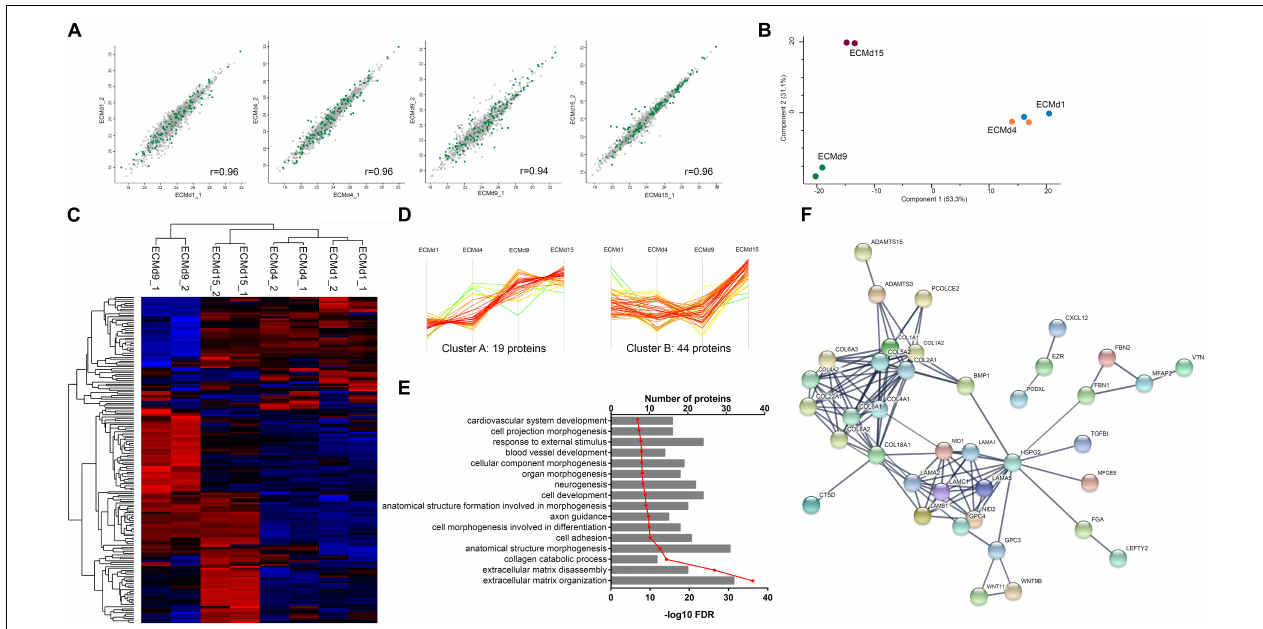
FIGURE 3 | Characterization of extracellular matrix obtained from decellularized EBs during cardiac differentiation of hESCs. (A) Pearson’s correlation of ECM replicates. (B) Principal component analysis of all analyzed samples. (C) Heatmap representing the hierarchical clustering of ECM samples. High z -scores and low z -scores are represented in red and blue, respectively. (D) Two defined clusters showing a pattern with higher z -scores at ECMd15 (cluster A: gradual increasing over time; cluster B: increase from days 9 to 15). Clusters displayed the z -score values over analyzed times. (E) GO enrichment analysis for biological process of proteins present at clusters A and B. (F) Representative network of protein–protein interactions based on STRING analysis of proteins present at clusters A and B.